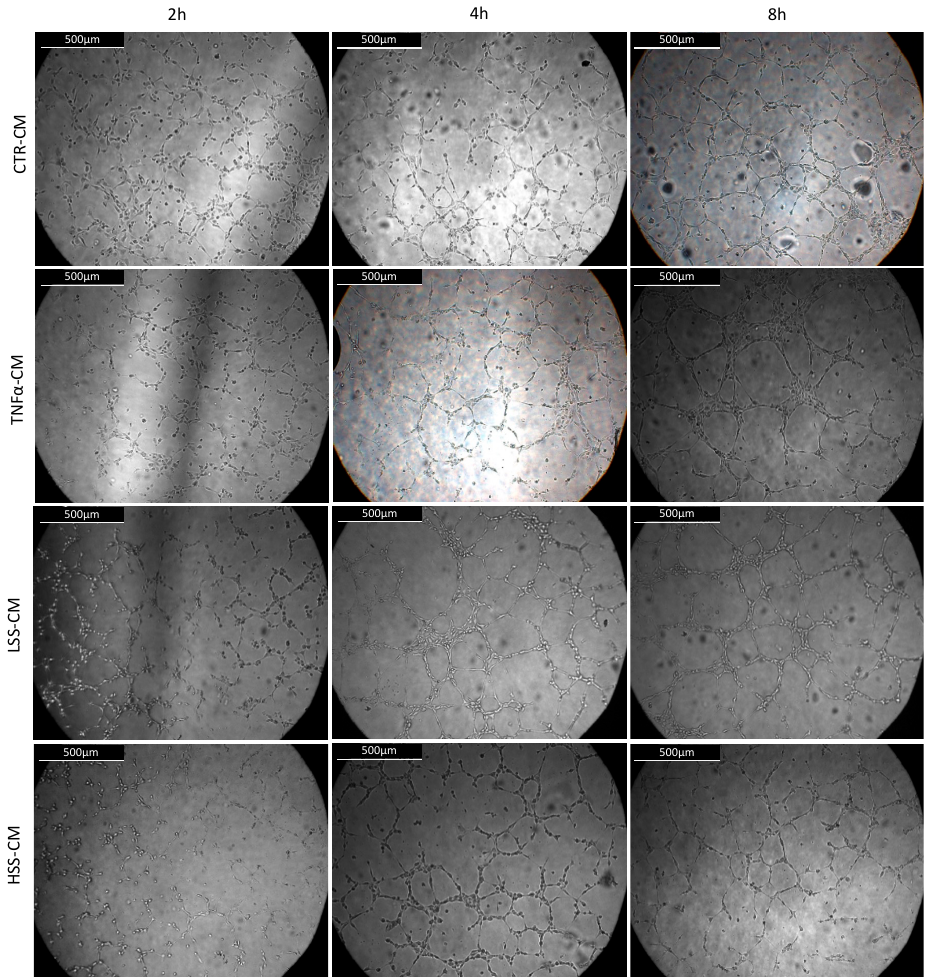
Figure 10. Tube formation assay on Matrigel. Representative bright field images of the same central area were taken at different time points per each condition. Scalebar: 500 μ m.